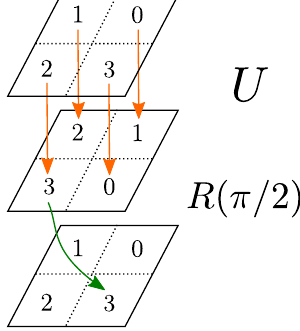
Figure 2: With two real order parameters φ fully breaking a (cid:90) symmetry we have 1,2 4 four ground states, labelled 0,1,2,3. These can be identified with the four signs of = ± . Choosing a boundary condition for the VEVs of the two order parameters φ 1,2 φ such that they wind the unit circle at infinity along a pair of spatial coordinates 1,2 we obtain a codimension-2 junction where four domain walls coalesce. The global (cid:90) symmetry does not act on this junction but we can combine it with a π/ 2 rotation 4 to obtain a (cid:90) symmetry of the junction. In this case, we did not use CPT , so both 4 (cid:90) symmetries are 4